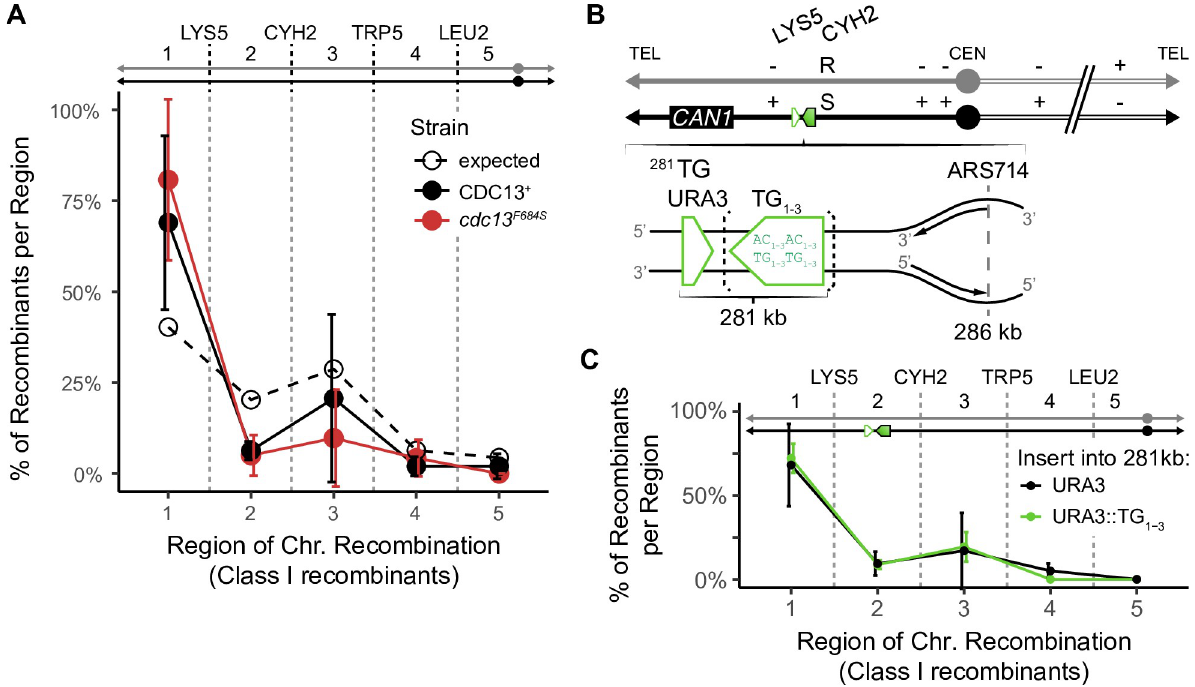
Fig 2. Unstable chromosomes in cdc13 F684S form at the telomere, not at internal TG repeats at a semi-restrictive temperature (30˚C). (A) Distribution of Class I recombinants from cdc13 F684S round colonies (solid) and the expected distribution (dashed; calculated from the proportion of the region length vs total length of the chromosome arm). The average percentage and standard deviation for 4 independent experiments are shown ( P = 0.0349; one sample t test). (B) Schematic for insertion of the TG 1-3 repeat (green box) into the left arm of Chr VII. The TG 1-3 insert (green box; bracketed) was marked with URA3 (green triangle) and was inserted 281 kb from the telomere end. As a control, URA3 alone was inserted into the same region. (C) Distribution of Class I recombinants from round colonies from cdc13 F684S with URA3 or URA3 ::TG 1-3 inserted into the 281 kb locus. The average percentage and standard deviation for 3 independent experiments are